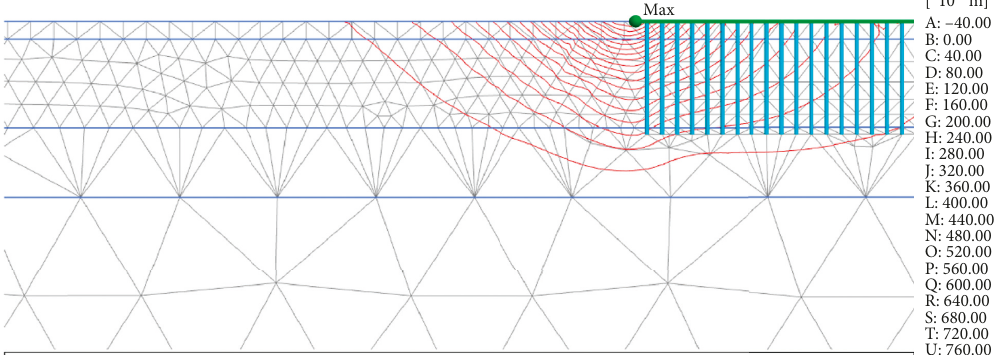
Figure 14: Lateral displacement of the soil outside Section 1.